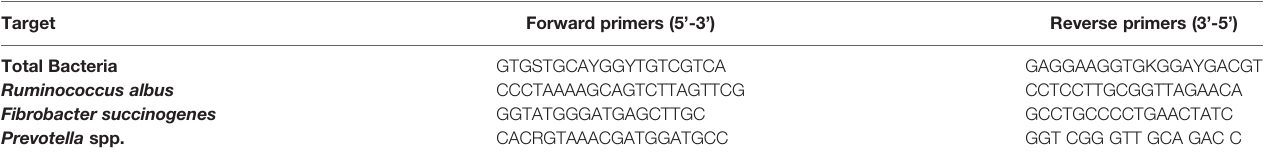
TABLE 1 | Forward and reverse primer sequences used to target 16S rDNA in qPCR analysis of total bacteria, Ruminococcus albus, Fibrobacter succinogenes and Prevotella spp. DNA concentrations.